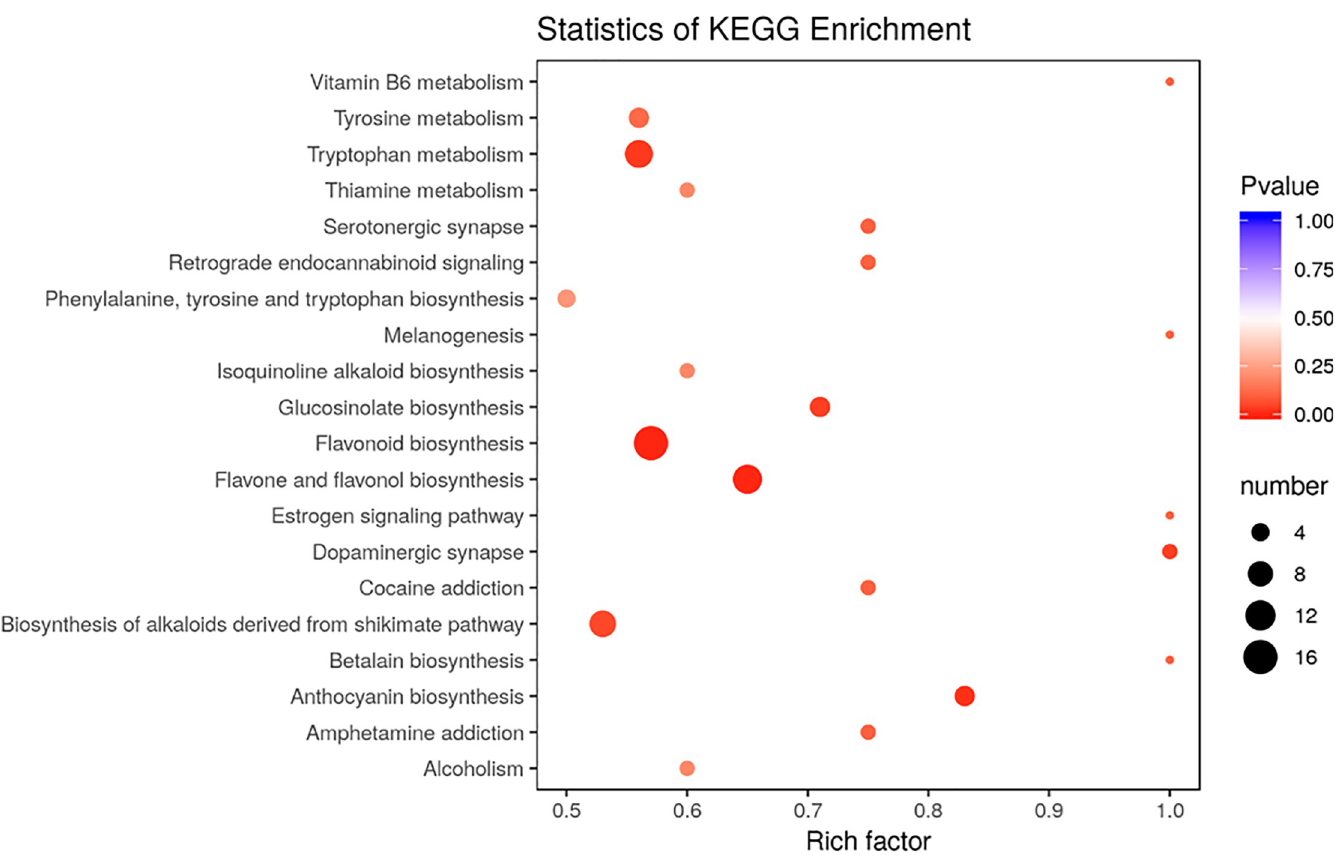
Fig 2. KEGG pathway enrichment analysis based on the differentially accumulated metabolites in SYQ purple and green leaves.